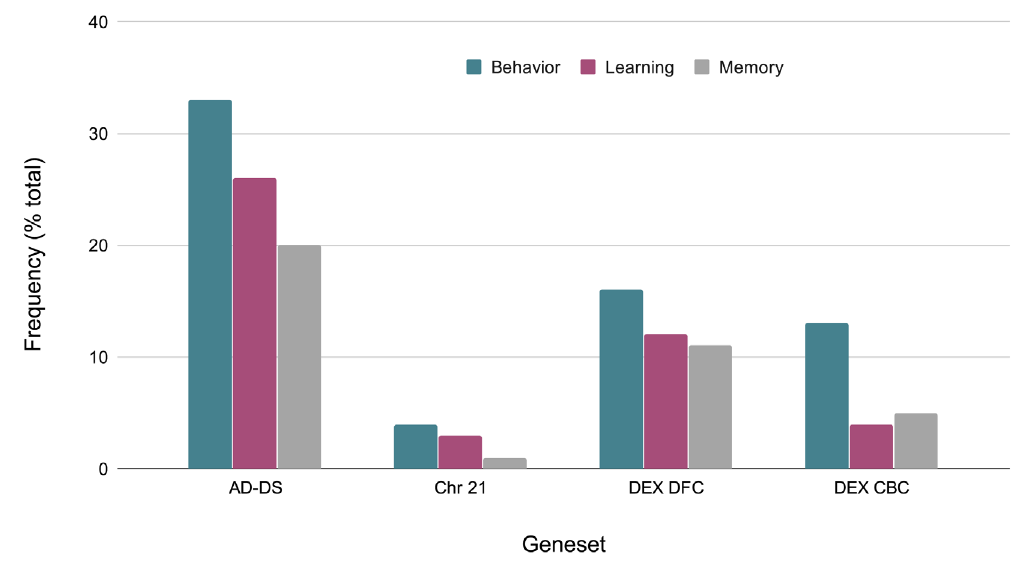
Figure 3. Evaluation of GO classification terms based on behavioral, memory, and learning categories. Comparison of frequencies of behavior related genes in the AD-DS, Chr 21, DEX DFC, and DEX CBC genesets. X-axis, geneset; Y-axis, frequency of occurrence (percentage of total genes) in the